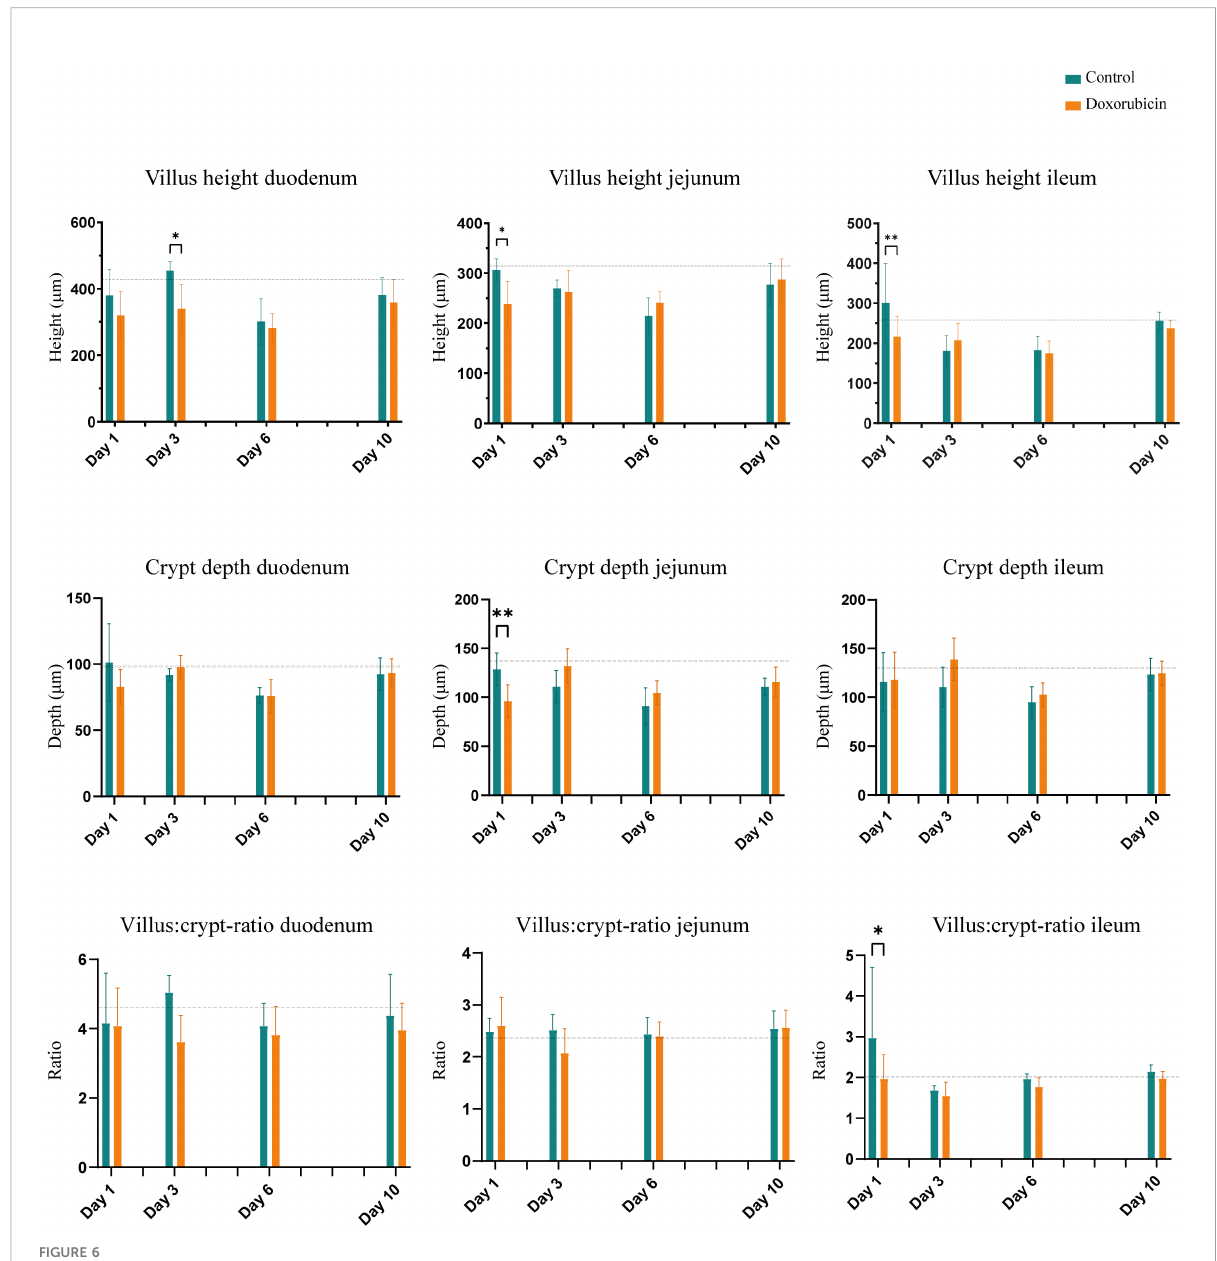
FIGURE 6 Histomorphological changes in the small intestine: Villus height, crypt depth, and villus:crypt-ratio. Baseline n = 6. For controls: day 1, n = 4; day 3, n = 4: day 6, n = 4; day 10, n = 7. For doxorubicin: day 1, n = 7; day 3, n = 8; day 6, n = 6; and day 10, n = 16. Data presented as mean ± sd. The dotted line represents the mean of the baseline values. *p < 0.05, **p <